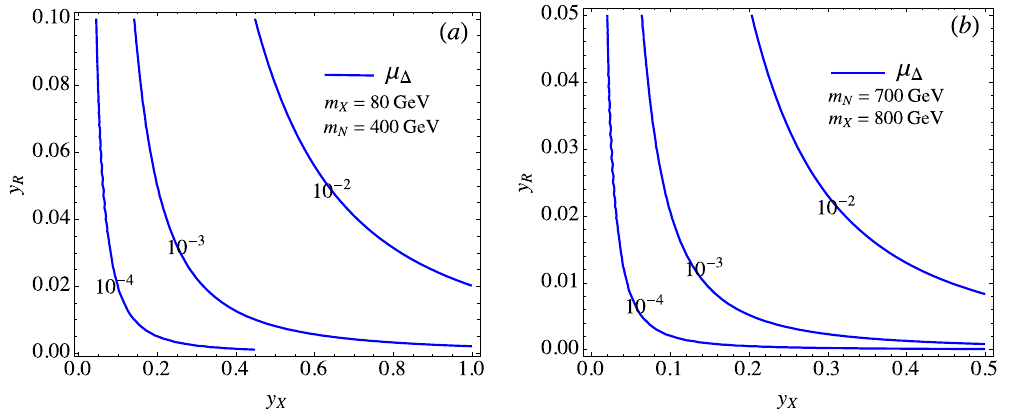
Figure 2 . Contours of (cid:22) (cid:1) as a function of y X and y R for (a) ( m X ; m N ) = (80 ; 400) GeV and (b) ( m X ; m N ) = (800 ; 700)